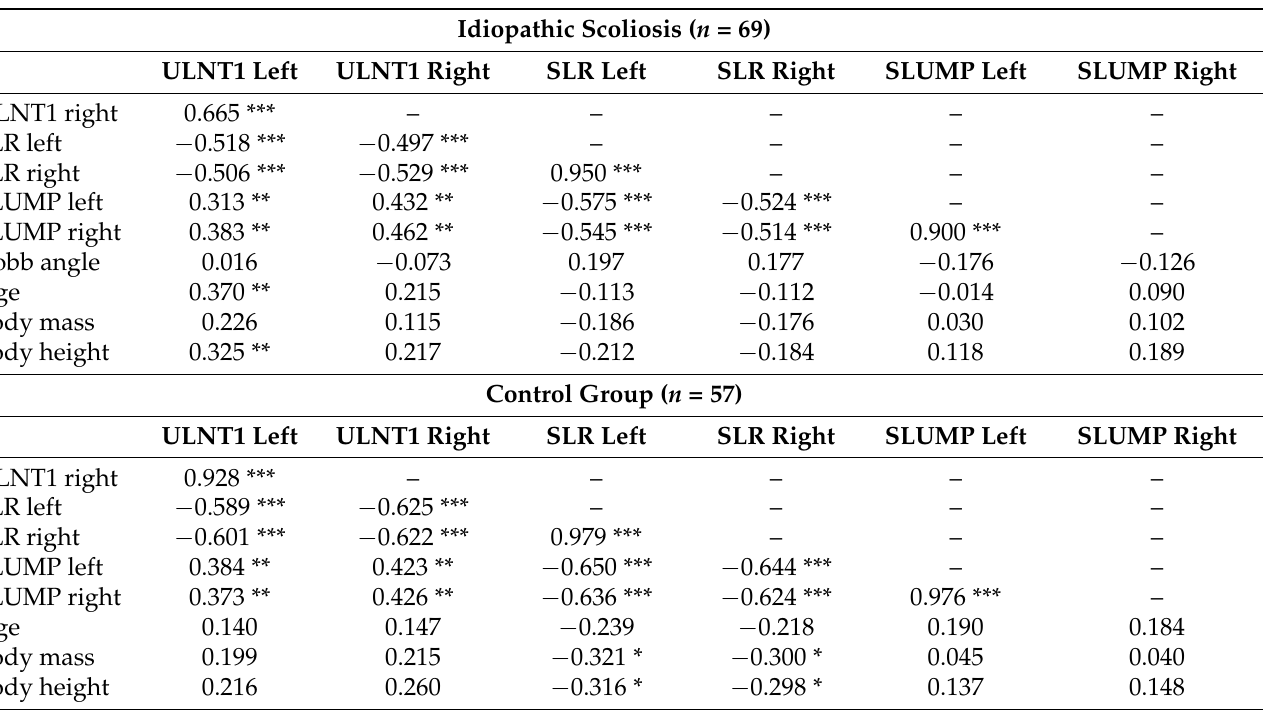
Table 3. Correlations between neurodynamic tests, Cobb angle, age, body mass and height in adolescents with idiopathic scoliosis (IS) and the control group